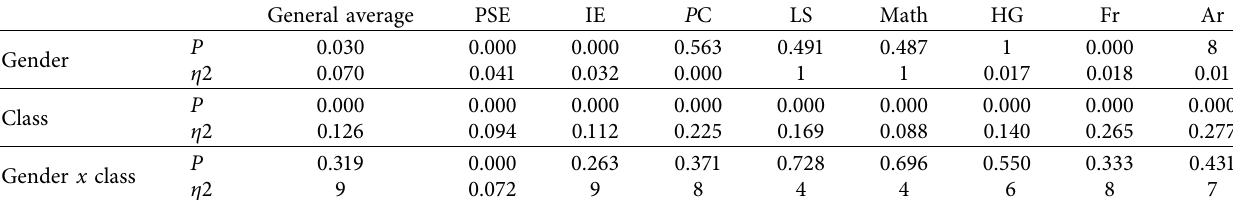
Table 8: Interaction of gender and class effects on educational outcomes (MANOVA I, II, and III).